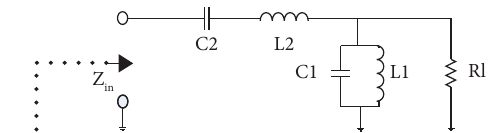
Figure 29: Te circuit with another branch of RCN and load.